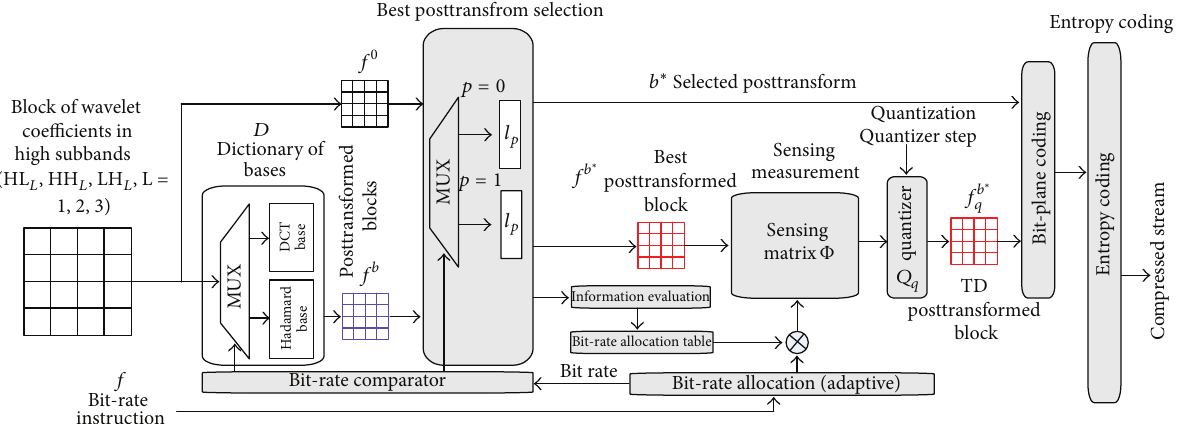
Figure 13: Proposed deep coupling